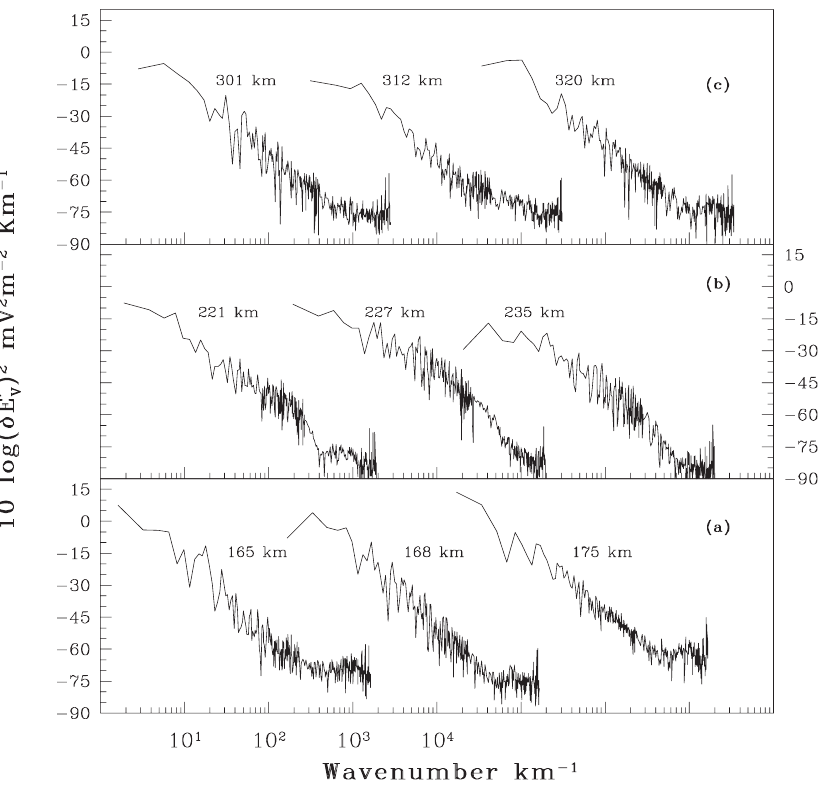
Fig. 6a–c. Spectra of vertical electric field fluctuations ( d E 0 ) at three representative V altitudes a at 160–190 km, b at 210–257 km and c at 290–330 km regions, which